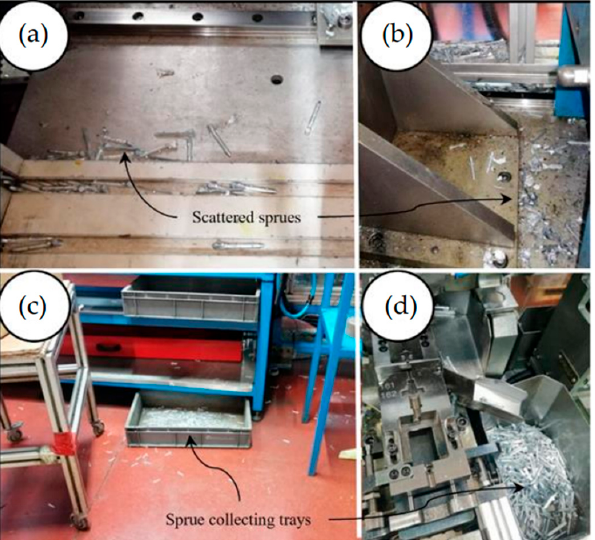
Figure 10. Scattered sprues on the work floor and palliative measures to contain them; ( a , b ) sprues scattered on the machine and its guides, ( c , d ) extra sprue containers placed as a palliative measure.